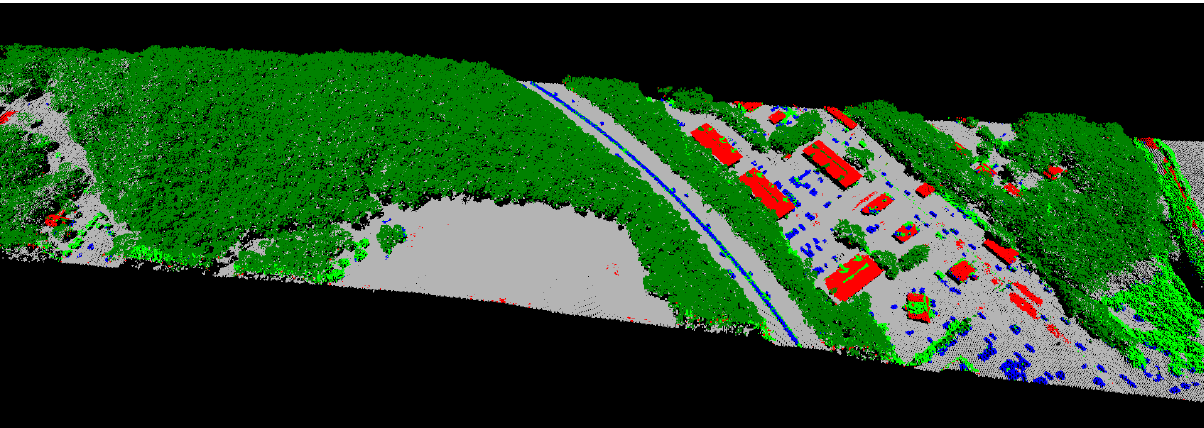
Figure 3. Classified point cloud for the Vaihingen Dataset with nine classes ( Roof : red; Fac¸ade : white; Impervious Surfaces : gray; Car : blue; Tree : dark green; Low Vegetation : bright green; Shrub : yellow; Fence / Hedge : cyan; Powerline : black).